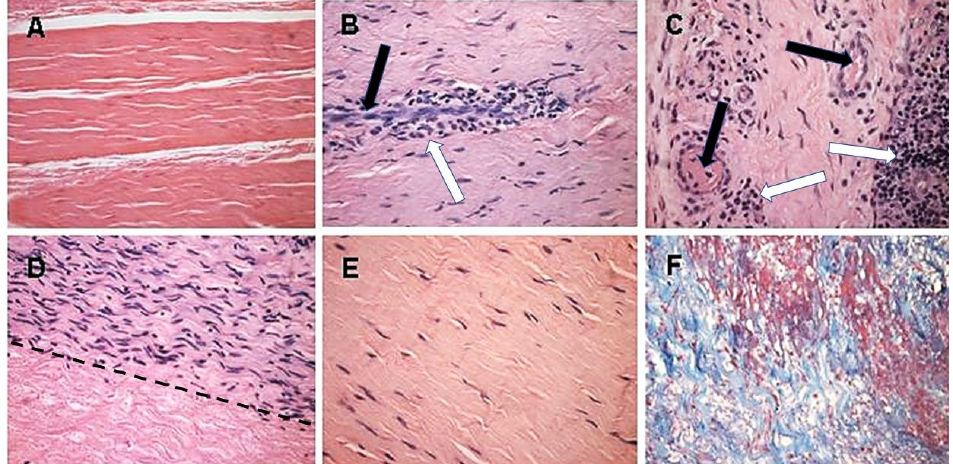
Figure 5. Histopathology demonstrating humanization stages in patients with implanted porcine BTB bioprostheses. Black arrows: blood vessels, white arrows: macrophages. ( A ) Pre-implantation porcine BTB bioprosthesis. ( B ) Infiltration of macrophages into the implanted bioprosthesis by extravasation. Elongated cells are endothelial cells of a blood vessel. ( C ) Vascularization of the implanted BTB in a region near macrophage infiltrates. ( D ) Repopulation of a section of the bioprosthesis by the recipient’s fibroblasts that aligned with the porcine collagen fiber scaffold (above the dashed line). Porcine collagen fibers and no cells, seen under the dashed line. ( E ) An advanced stage of humanization, with repopulating fibroblasts secreting their own ECM. ( F ) De novo produced collagen fibers, stained blue in Mason-trichrome staining. H&E, (×200) (modified from [71]).